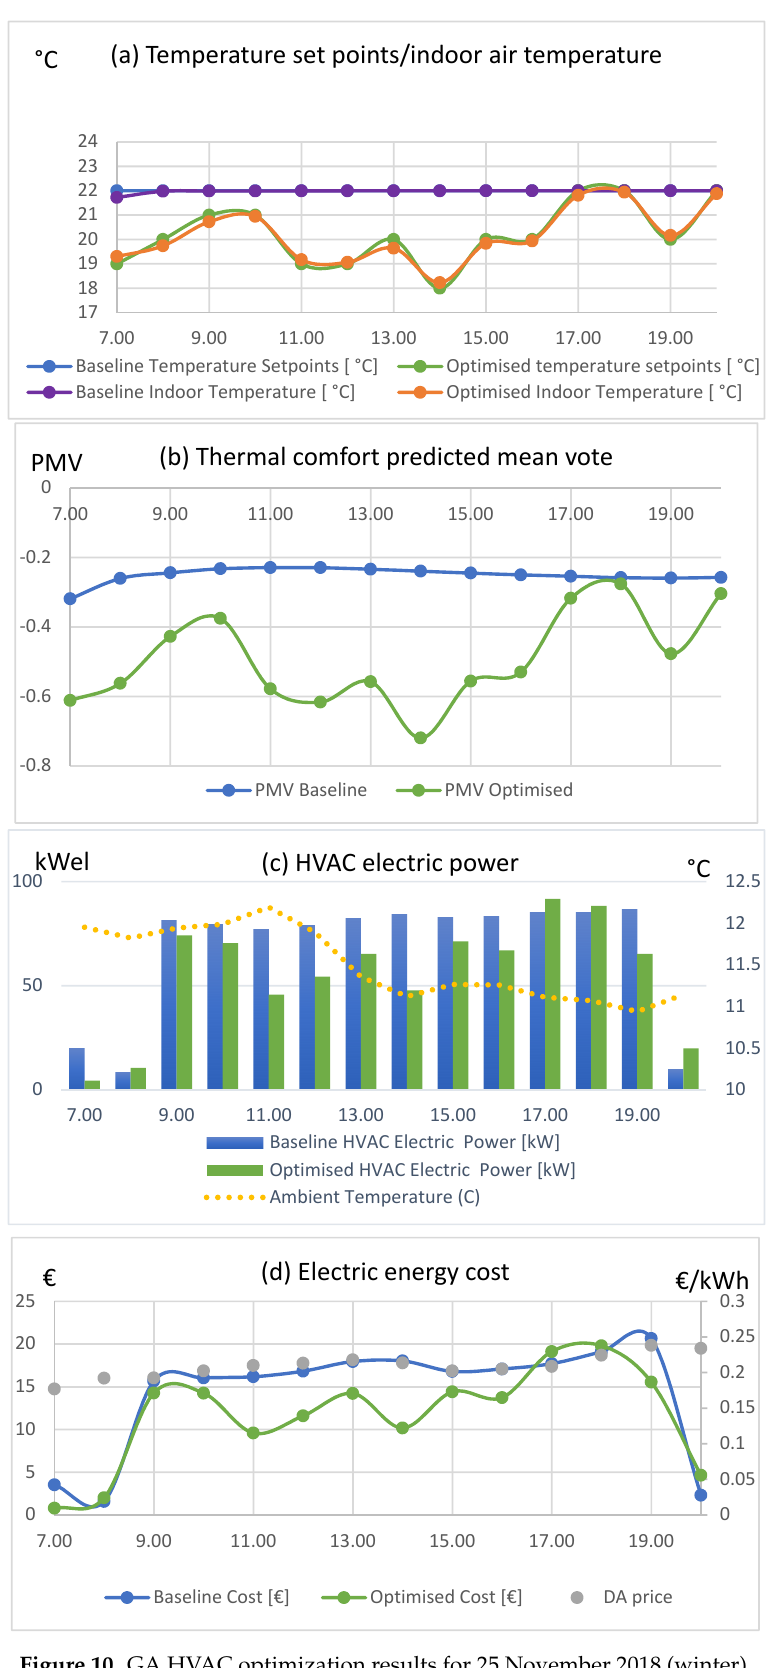
Figure 10. GA HVAC optimization results for 25 November 2018 (winter).